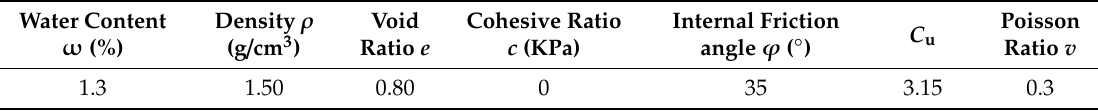
Table 1. Physical and mechanical parameters of